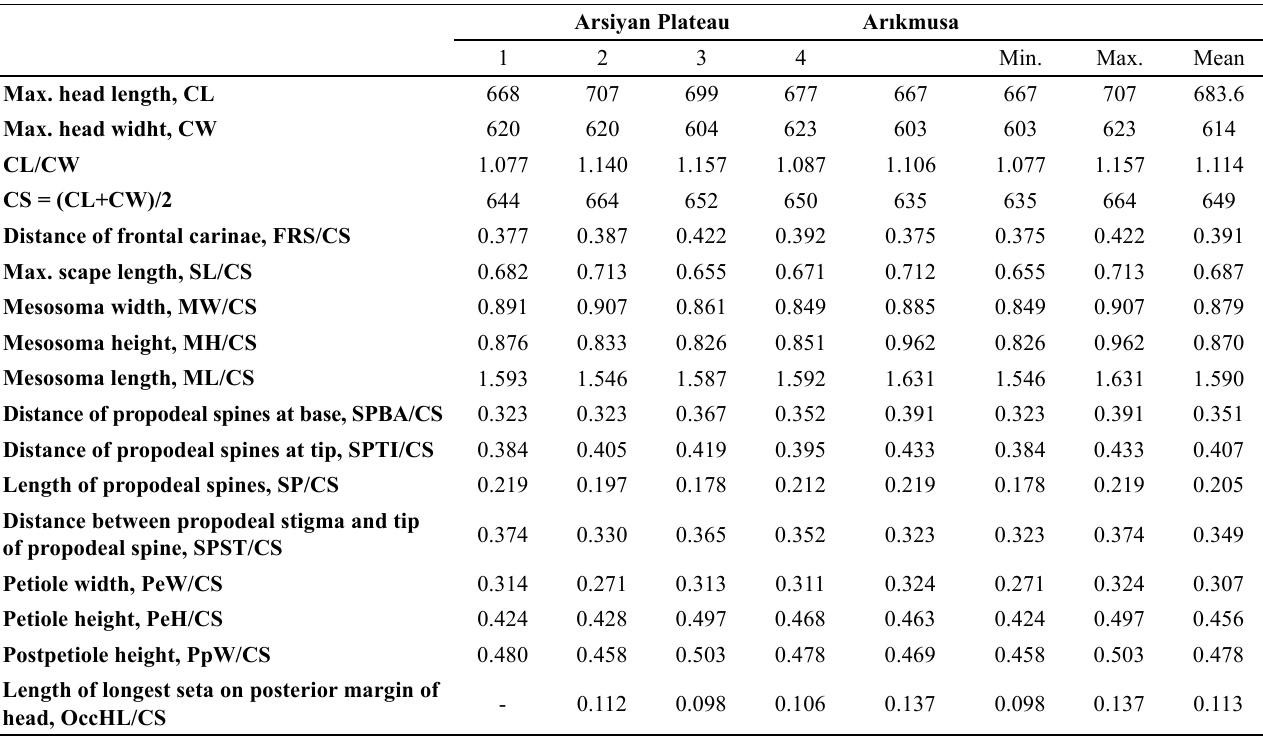
Table 2 . Morphometry of female sexuals of the inquiline ant Leptothorax kutteri collected in two sites in Turkey. Measures are as defined by Seifert